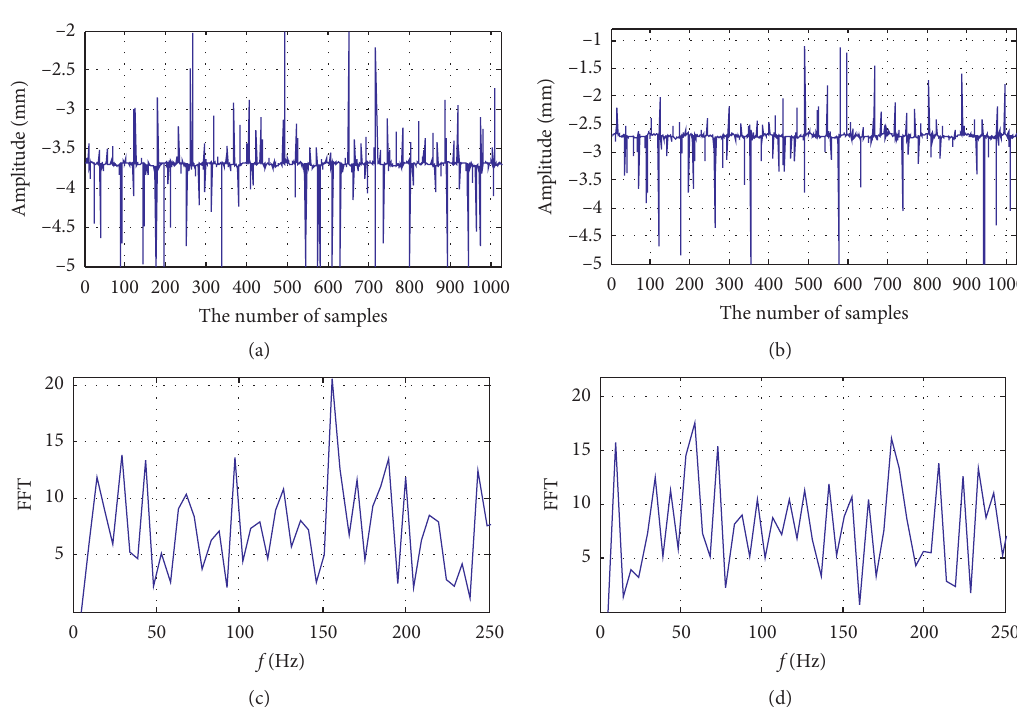
Figure 6: Time-domain and frequency-domain waveforms of rotor vibration signals.